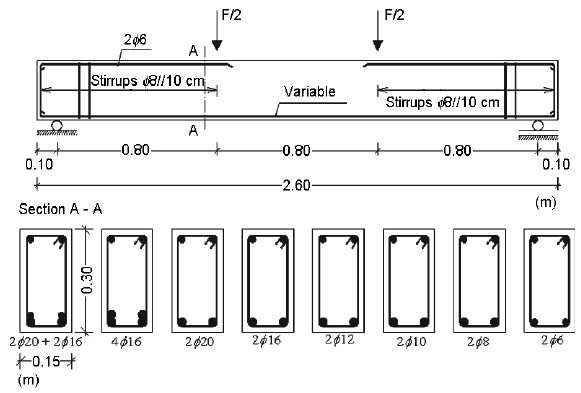
Fig. 1. Geometry and details of test